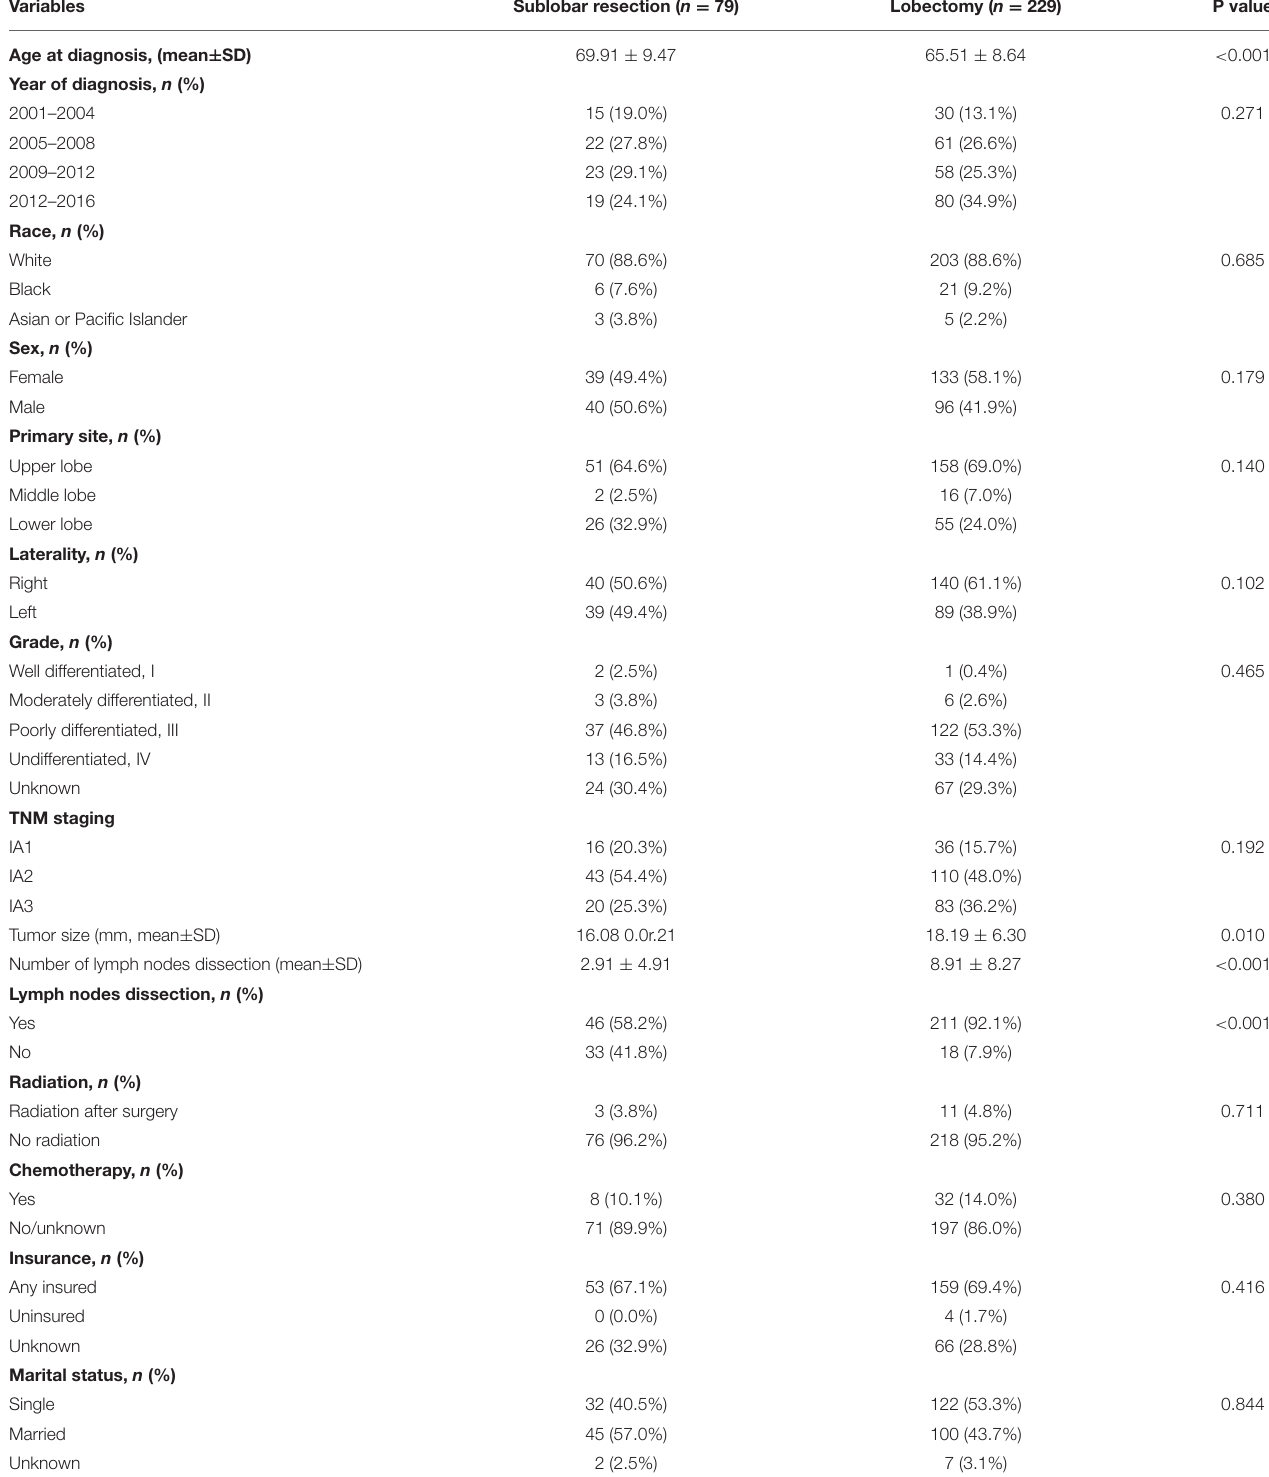
TABLE 1 | Patients’ characteristics between sublobar resection and lobectomy group before propensity score matching.